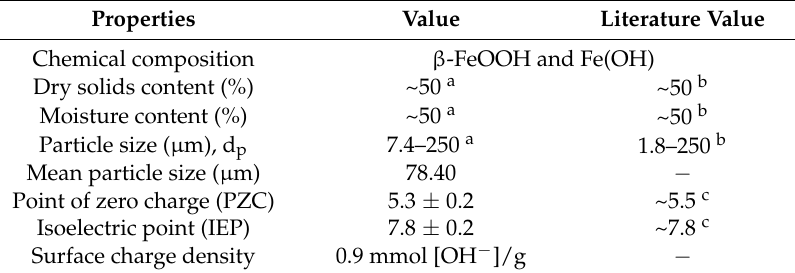
Table 1. Main properties of used DFH material.